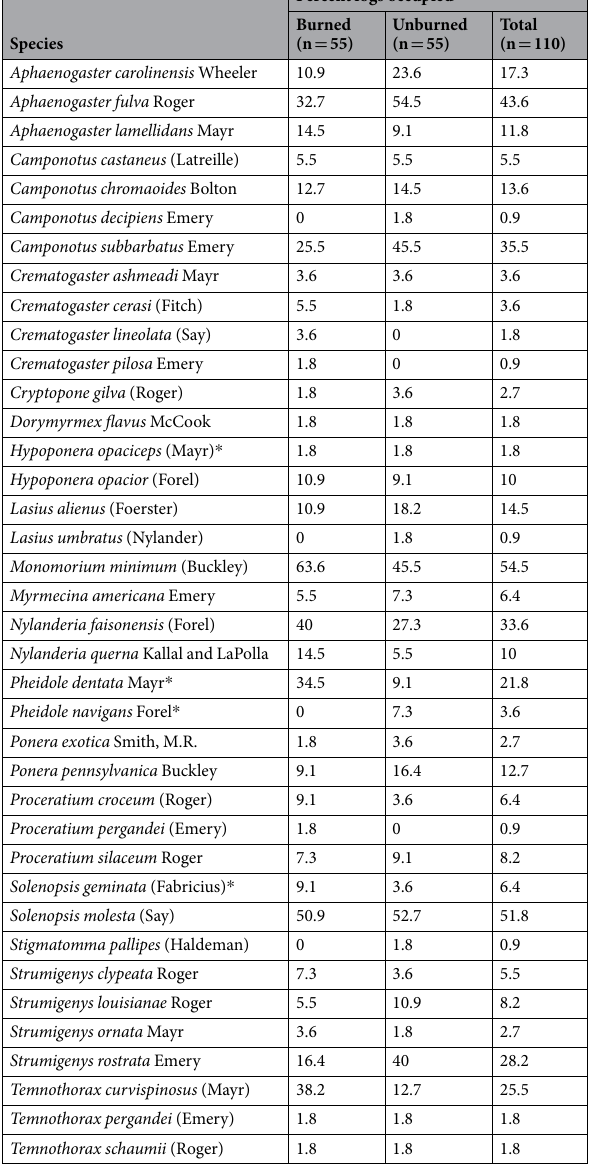
Table 1. List of ant species collected in this study and the percent log occupancy for each by burn treatment and in total. Asterisks indicate non-native